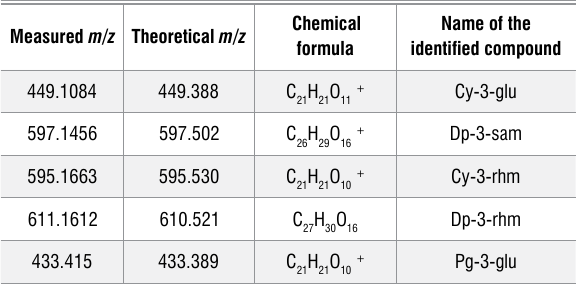
Table 4: L iquid chromatography quadrupole time-of-flight mass spectrometry ( LC-Q-TOF-MS) identification Measured m / z Theoretical m / z